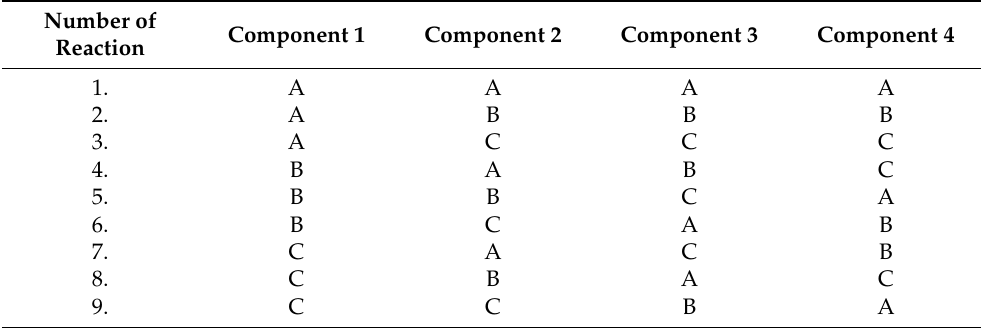
Table 1. Scheme of optimization of RAPD reaction according to Taguchi and Wu—orthogonal arrays for four components at three different